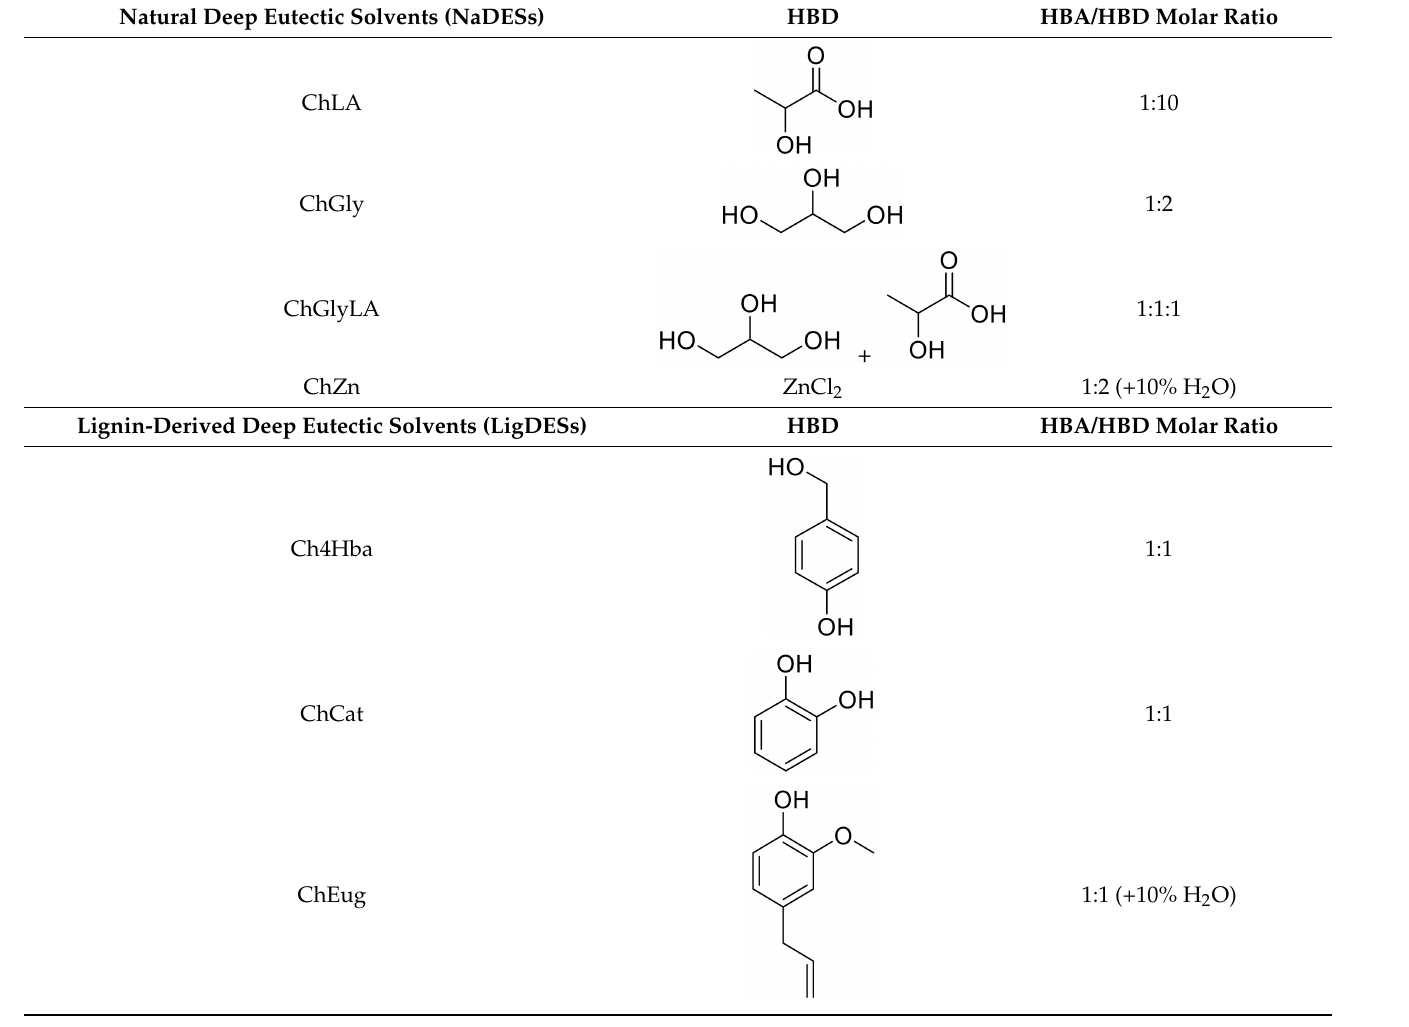
Table 1. Natural deep eutectic solvent (NaDES) and lignin derived NaDES (LigDES). Abbreviations, hydrogen bonding donor (HBD) structures and molar ratios. Water addition is expressed as w/w percentage. Natural Deep Eutectic Solvents (NaDESs) HBD HBA/HBD Molar Ratio